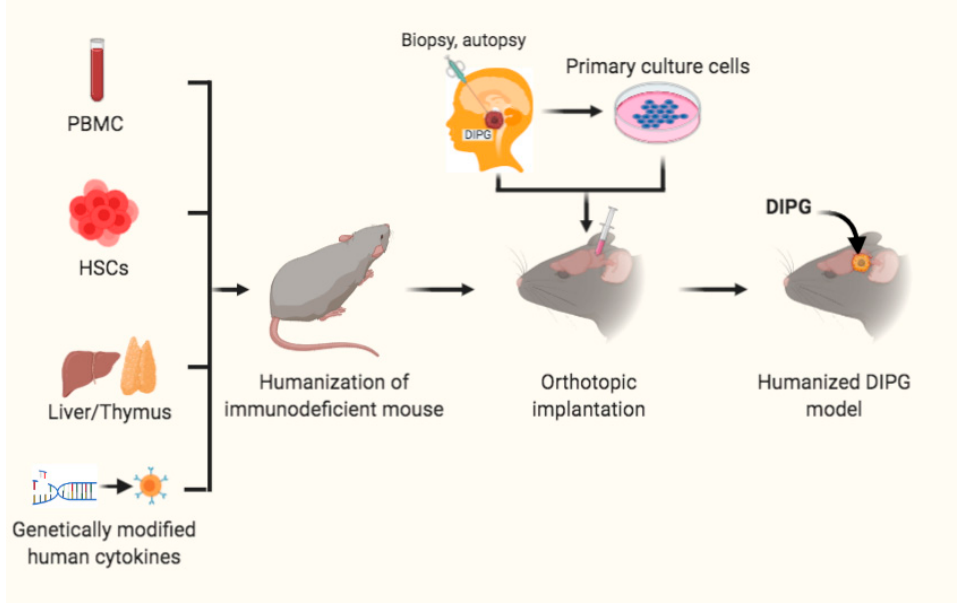
Figure 4. Humanized mouse models for DIPG. Immunodeficient mice received peripheral blood mononuclear cells (PBMCs), or hematopoietic stem cells (HSCs) and transplantation of liver/thymus, or genetically modified human cytokines prior to orthotopic intracranial inoculation of DIPG cells, from patient biopsy or autopsy specimens or primary cultured cells, into the pons to develop humanized DIPG models.